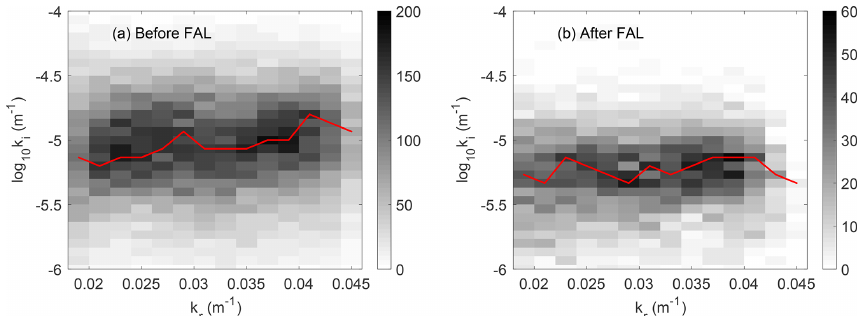
Figure 5. Smoothed two-dimensional histograms of the ice-induced attenuation rate k i against wave number k r (a) before the FAL and (b) after the FAL. The attenuation domain is equally divided into 30 bins in the log scale from 10 − 6 to 10 − 4 m − 1 . The gray scale indicates the occurrence of k i in each k i – k r bin from the selected pairs. The red curve indicates the highest occurrence of k i against k r